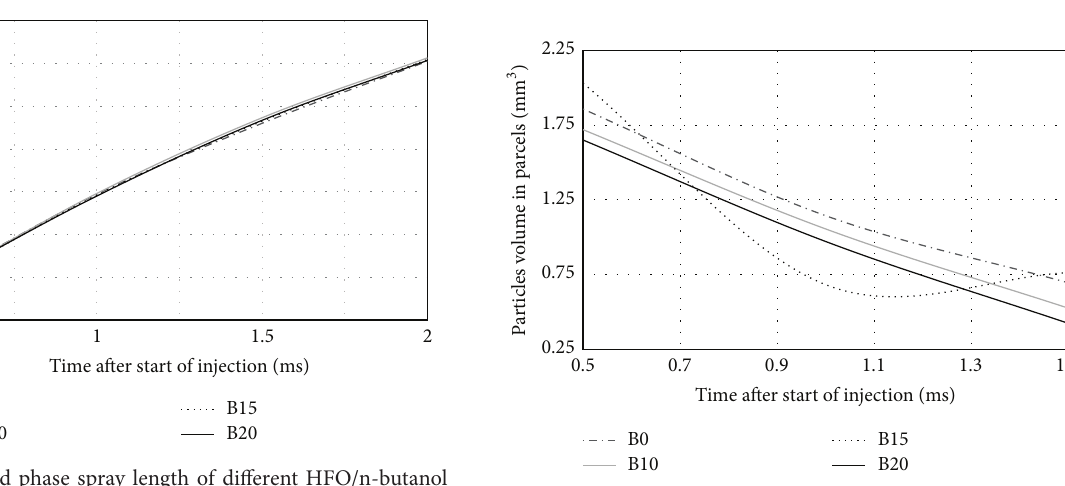
Figure 16: Particles volume in parcels at different HFO/n-butanol blends at injection pressure of